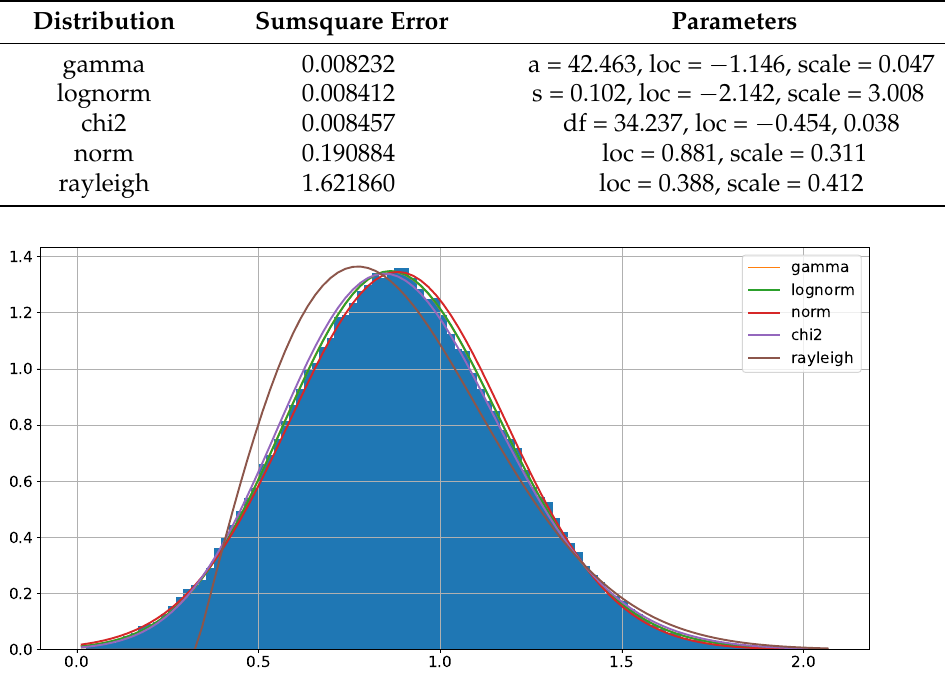
Figure 3. Fitting of different probability density functions to the histogram of the PSD